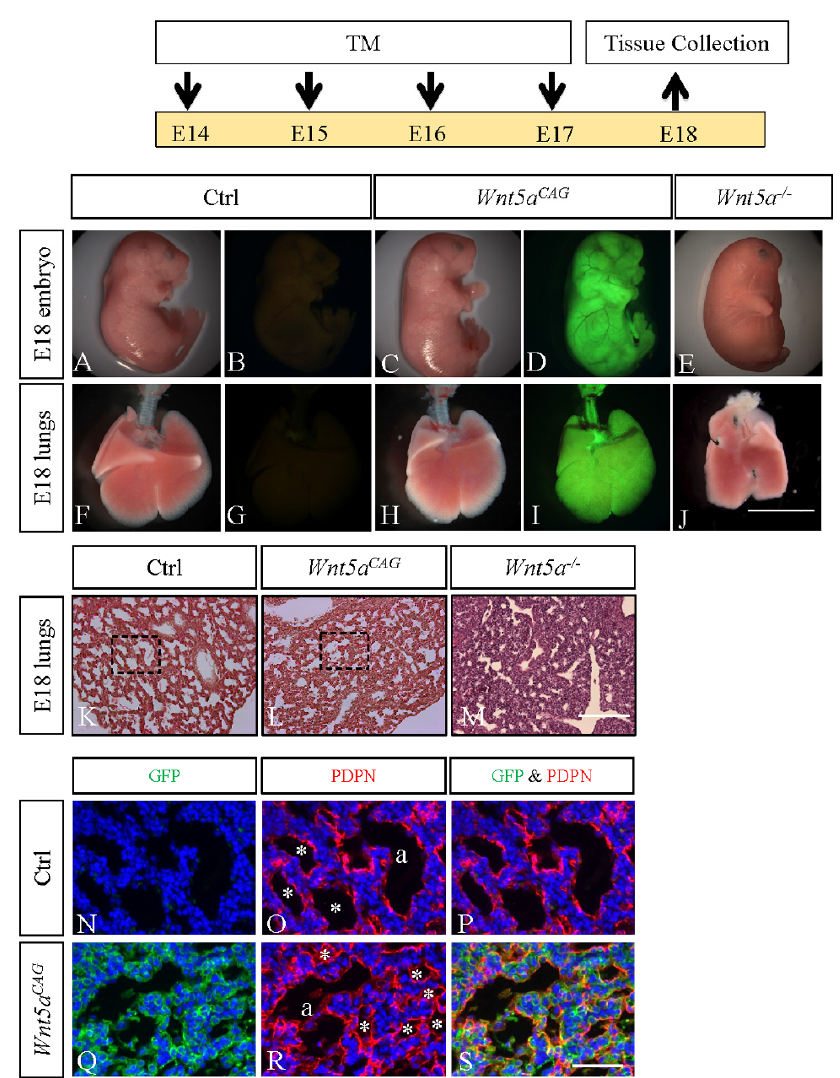
Figure 1. Wnt5a inactivation attenuated saccular stage lung development. Top: Schematic of the experimental plan. A – E : Gross morphology of E18 control ( A and B ), Wnt5a CAG ( C and D ) and Wnt5a - / - ( E ) embryos. Panels A , C and E show the bright-field images. Panels B and D show the green fluorescent images of control and Wnt5a CAG embryos, respectively. F – J: Gross morphology of E18 control ( F and G ), Wnt5a CAG ( H and I ) and Wnt5a - / - ( J ) lungs. Panels F , H and J show the bright-field images. Panels G and I show the green fluorescent images of control and Wnt5a CAG lungs, respectively. Scale bars ( J ): 10 mm for A – E , 4 mm for F – J . K – M : H&E staining of E18 control ( K ), Wnt5a CAG ( L ) and Wnt5a - / - ( M ) lungs. Scale bar (M): 200 µ m for K–M. N – S : Immunostaining of GFP (green) and PDPN (red) in E18 control ( N – P ) and Wnt5a CAG ( Q – S ) lungs. Panels N – P and Q – S correlate to the boxed areas in Panels K and L , respectively. Asterisk indicates saccules. “a” indicates the junction between bronchiole and saccules. Scale bars ( S ): 50 µ m for N – S .